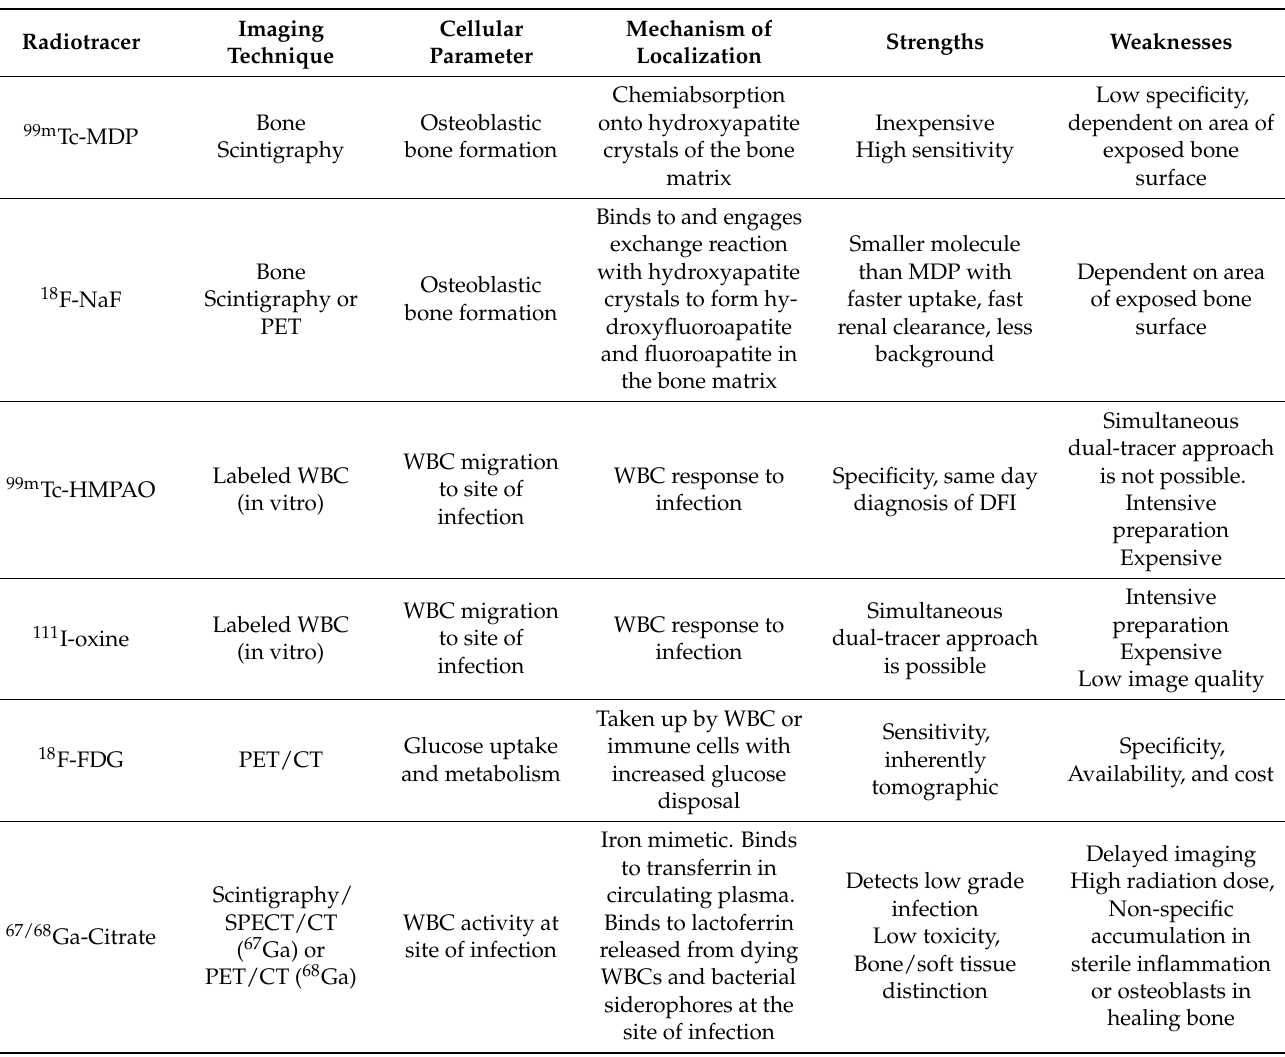
Table 3. Common Molecular Imaging